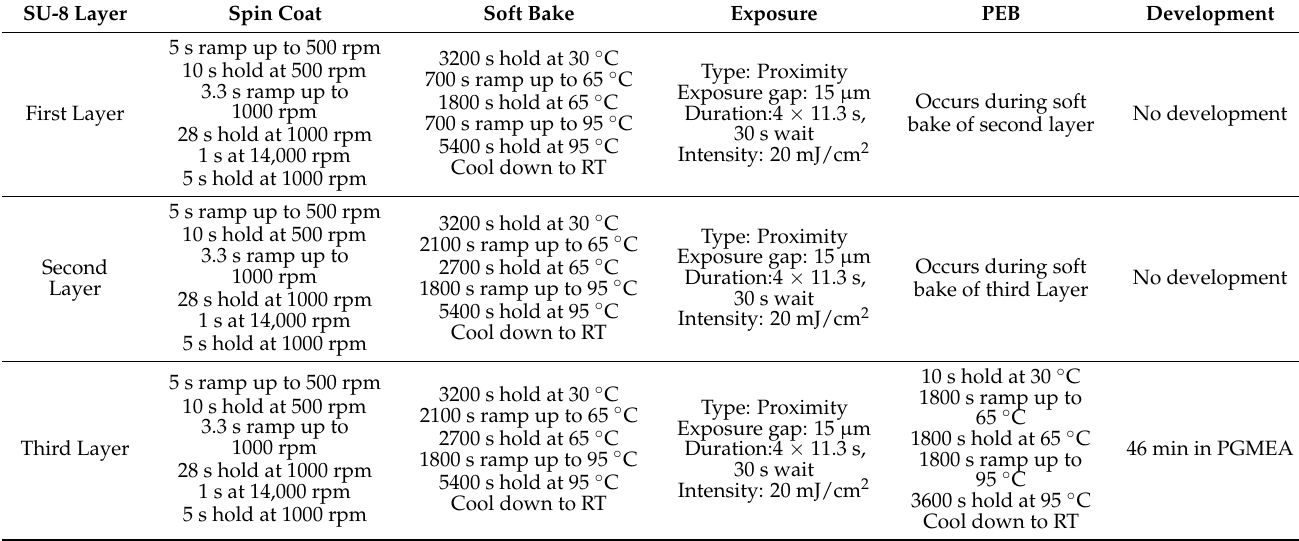
Table 1. Fabrication protocol for 1 mm high pillars using three SU-8 layers and a single